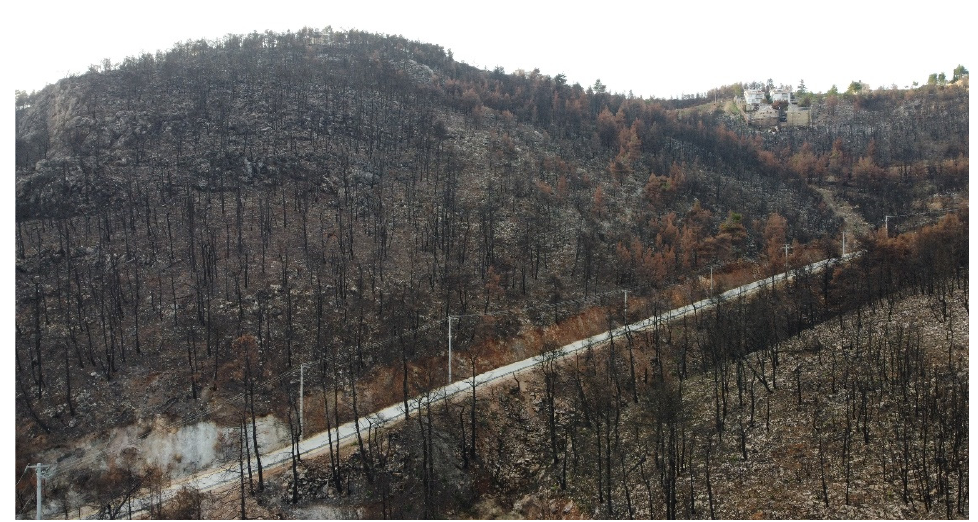
Figure 3. Part of the burnt area at Varimpompi on 6 November 2022. The exact location of Varimpompi in the wider area of Attica is shown on the map of Figure 2.